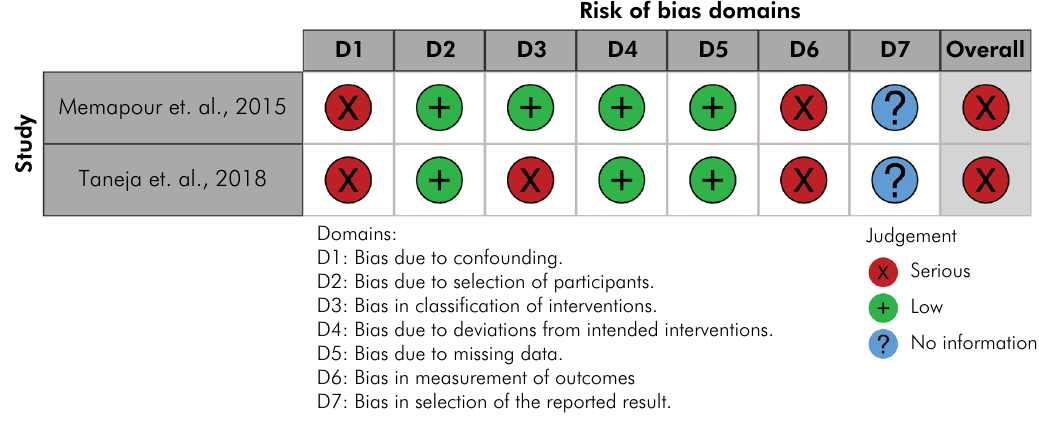
Figure 3. Quality assessment of included studies according to ROBINS-I